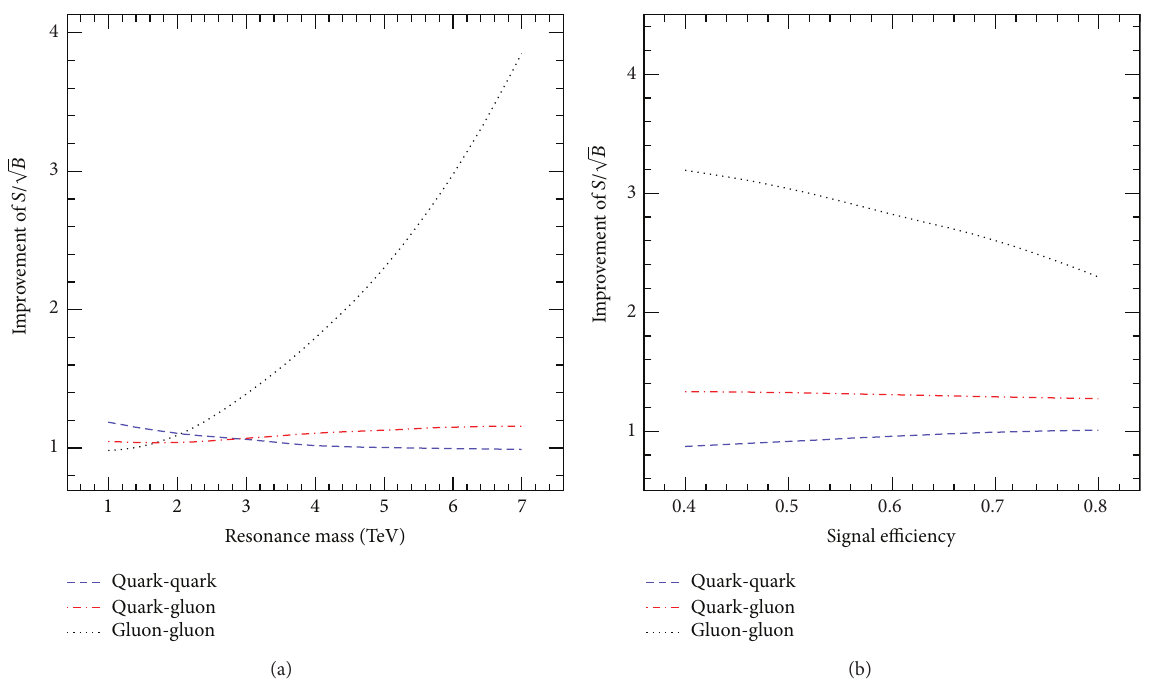
Figure4:(a)Improvementofsignalsignificanceratioasafunctionofresonancemassafterapplyingpartontagging.Thetaggingdiscriminator is chosen at 80% signal efficiency. (b) Improvement of signal significance as a function of signal efficiency cut at the resonance mass of 5TeV. In both plots, black dashed line shows gluon-gluon resonances, red dashed line present quark-gluon resonances, and purple dashed line shows quark-quark